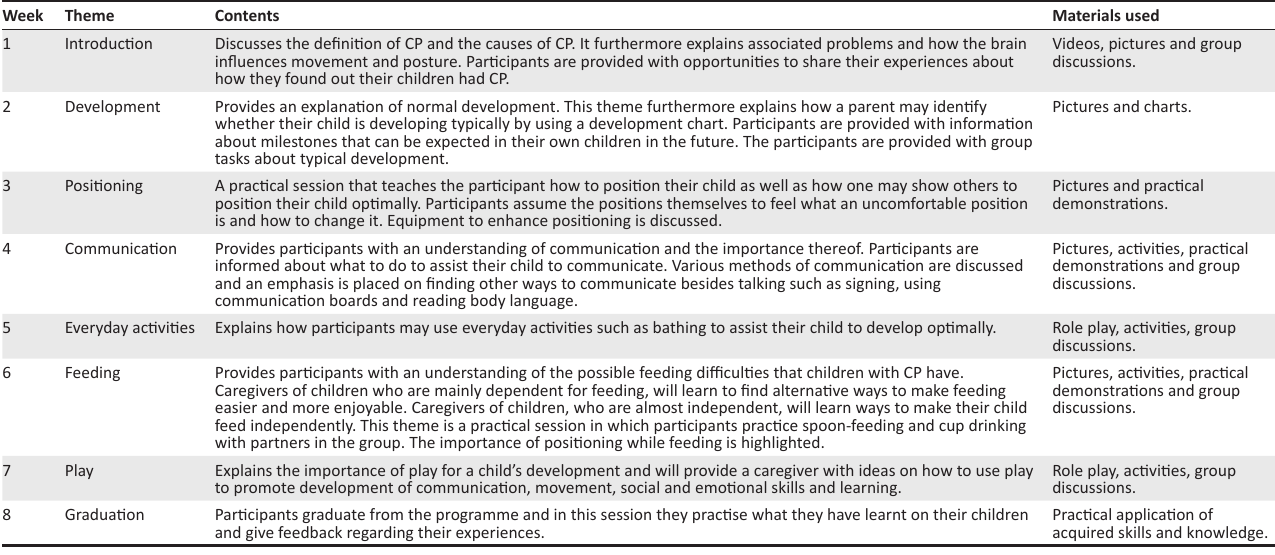
TABLE 1: Hambisela programme